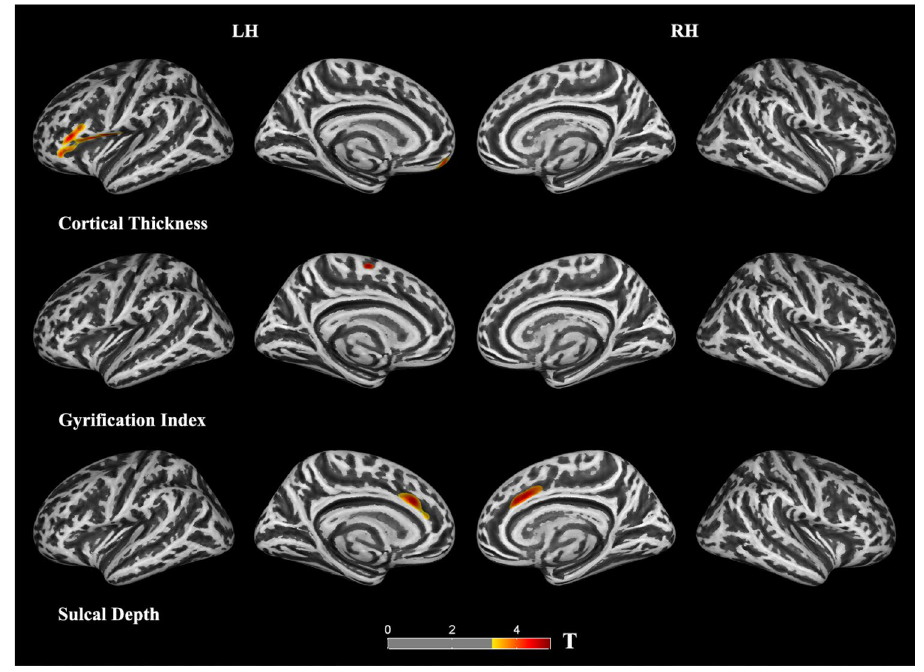
Figure 1. Clusters showing significantly changed cortical morphology in the trigeminal neuralgia (TN) patients compared to the healthy controls (HCs). LH (RH): left (right)